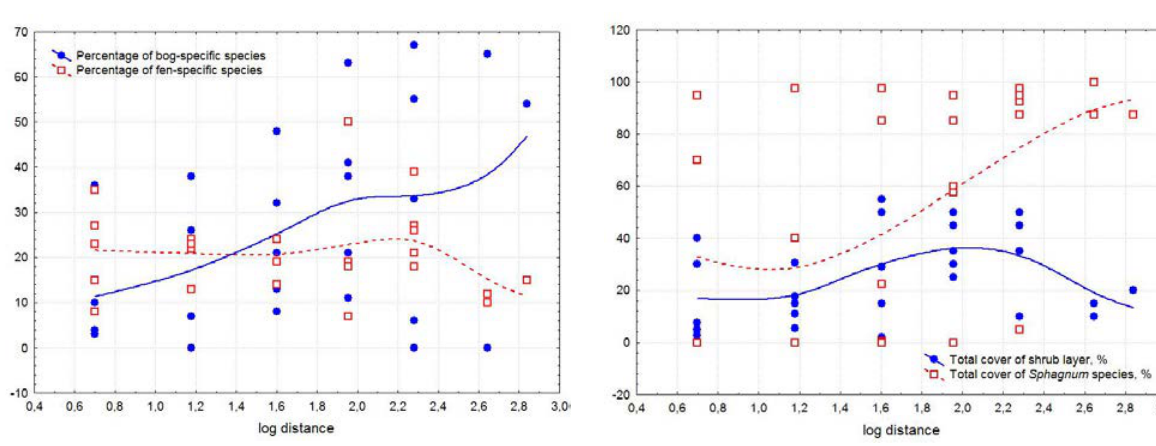
Figure 14. Relationships between total cover of shrub layer and total cover of Sphagnum species, and log-distance from the cutoff